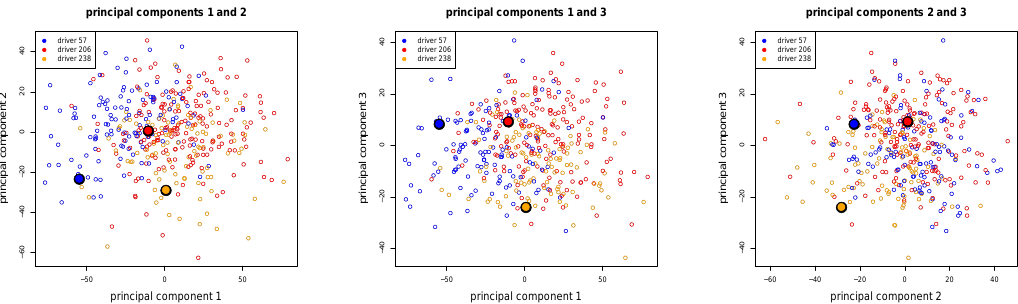
Figure 16. The first three principal components of the n = 416 drivers illustrated in two-dimensional scatter plots, colored according to the ConvNet classification of Table 6, the three selected drivers 57, 206 and 238 are illustrated by bigger